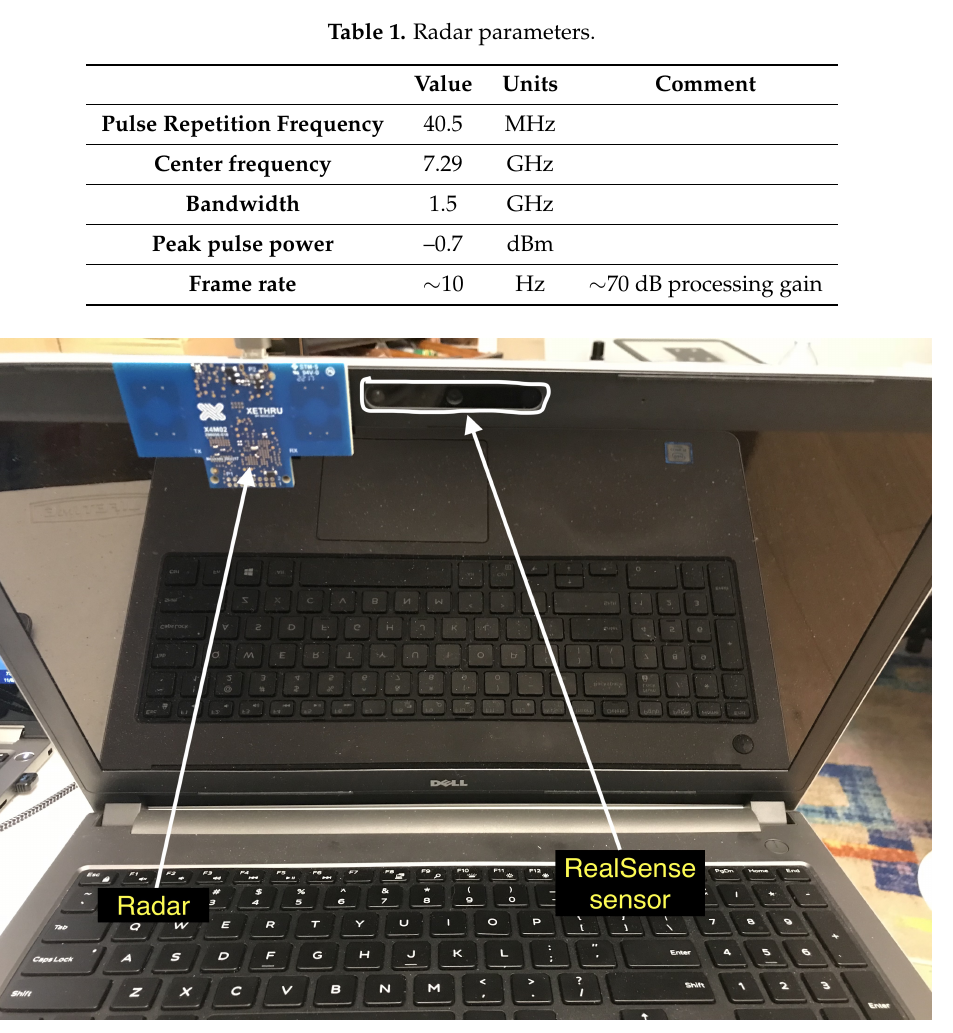
Figure 1. Xethru X4 radar mounted to a laptop with RealSense sensor on